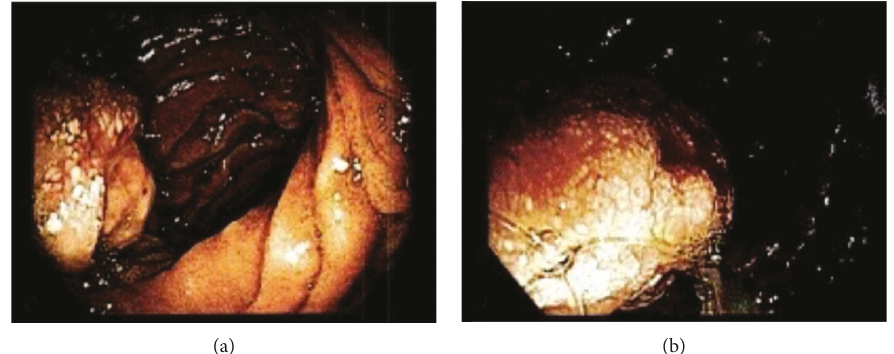
Figure 2: Endoscopic images of the large ulcerated mass found in the second/third portion of the duodenum. There was no bleeding stigmata at the time of